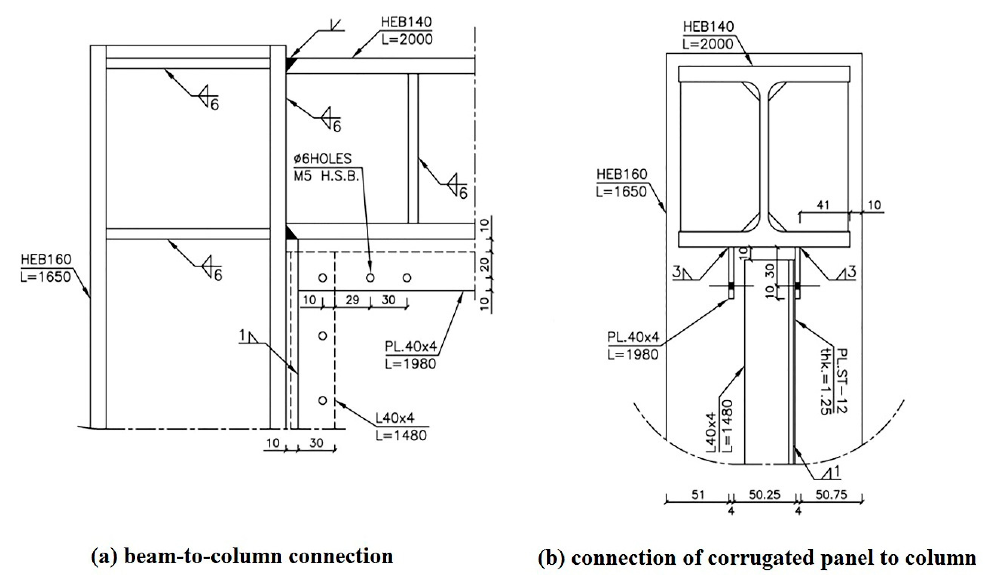
Figure 4. Details of connections.